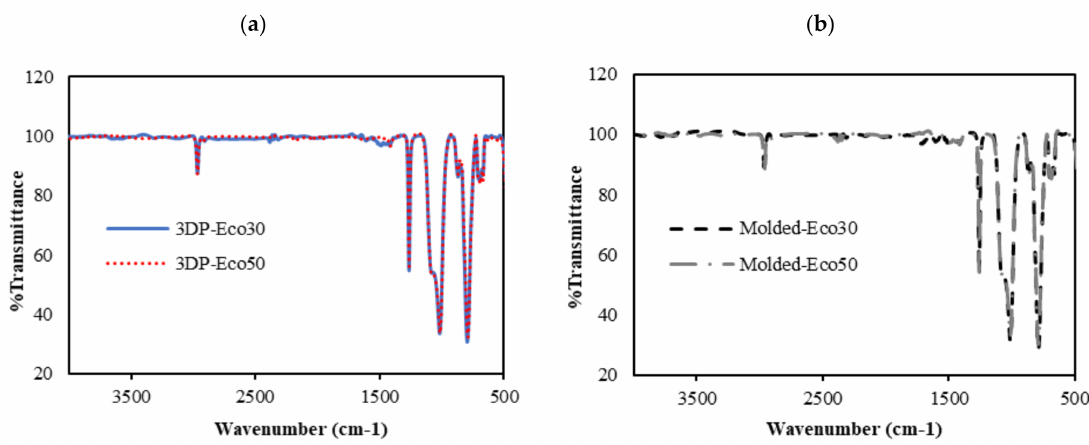
Figure 9. FTIR absorbance spectra of ( a ) 3D printed silicone implant and ( b ) molded silicone